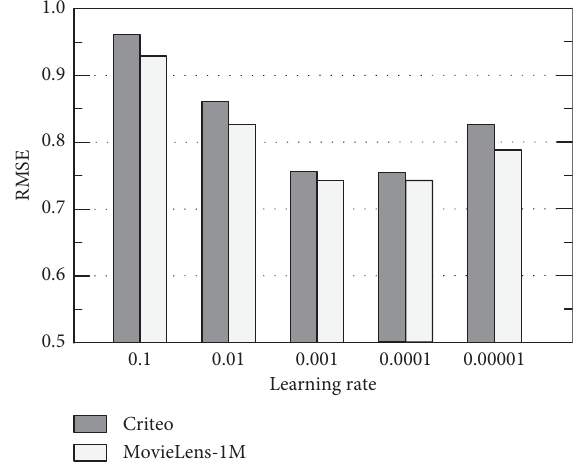
Figure 5: Efects of diferent learning rates on